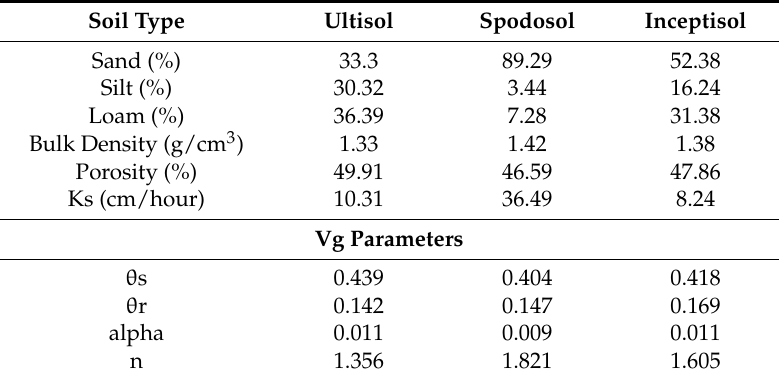
Table 1. Soil properties and van Genuchten parameter of soil type